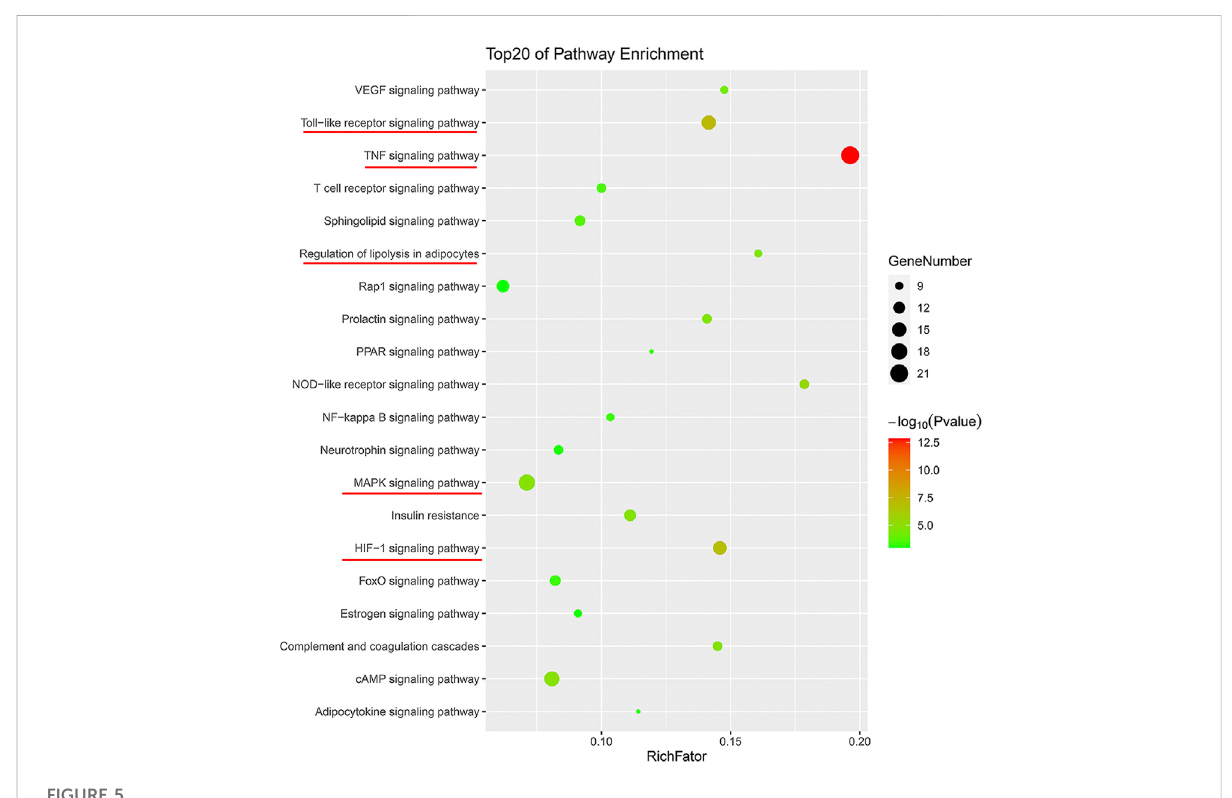
FIGURE 5 Top 20 enriched pathways of GLXB on